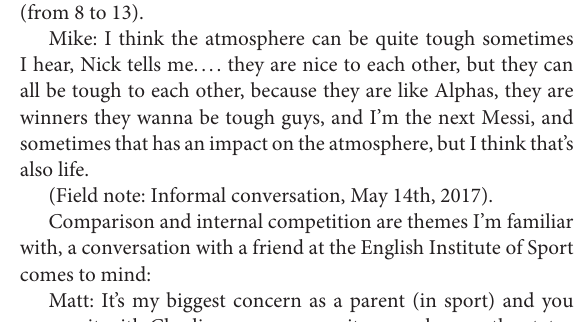
team and the decision to increase the age of the academy intake (from 8 to